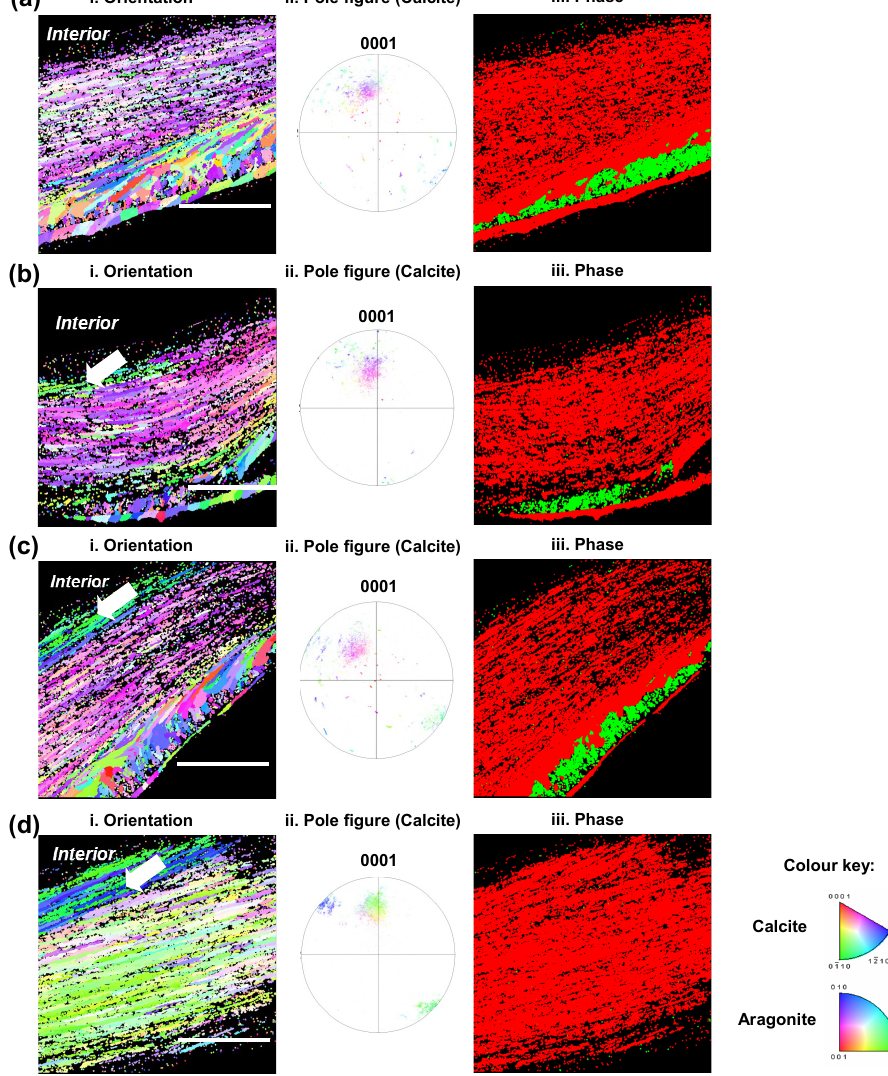
Figure 4. Electron back-scattered diffraction analyses of shells grown for 35 days at control pH 8.1 (a) , treatment pH 7.8 (b) , pH 7.5 (c) and pH 7.2 (d) . Crystallographic orientation maps (left column) of calcite crystals in reference to the { 0001 } plane and aragonite crystals in reference to the { 001 } plane. Crystallographic planes of calcite are colour-coded according to the normal crystallographic direction shown in the colour key (Perez-Huerta and Cusack, 2009). Pole figures for calcite (centre column) corresponding to the crystallographic orientation maps with the same colour key. The right column shows the phase maps of calcite exhibited in red and aragonite in green. The white arrow denotes a change in colour of 5 to 10 marginal foliated laminates. Scale bar =